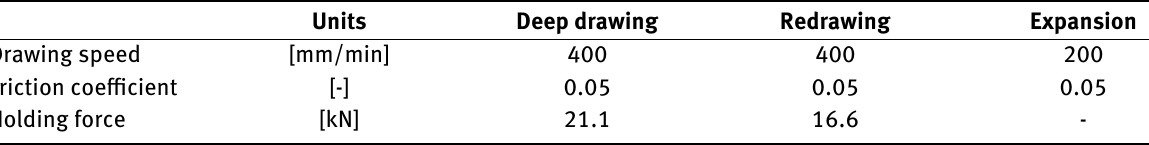
Units Deep drawing